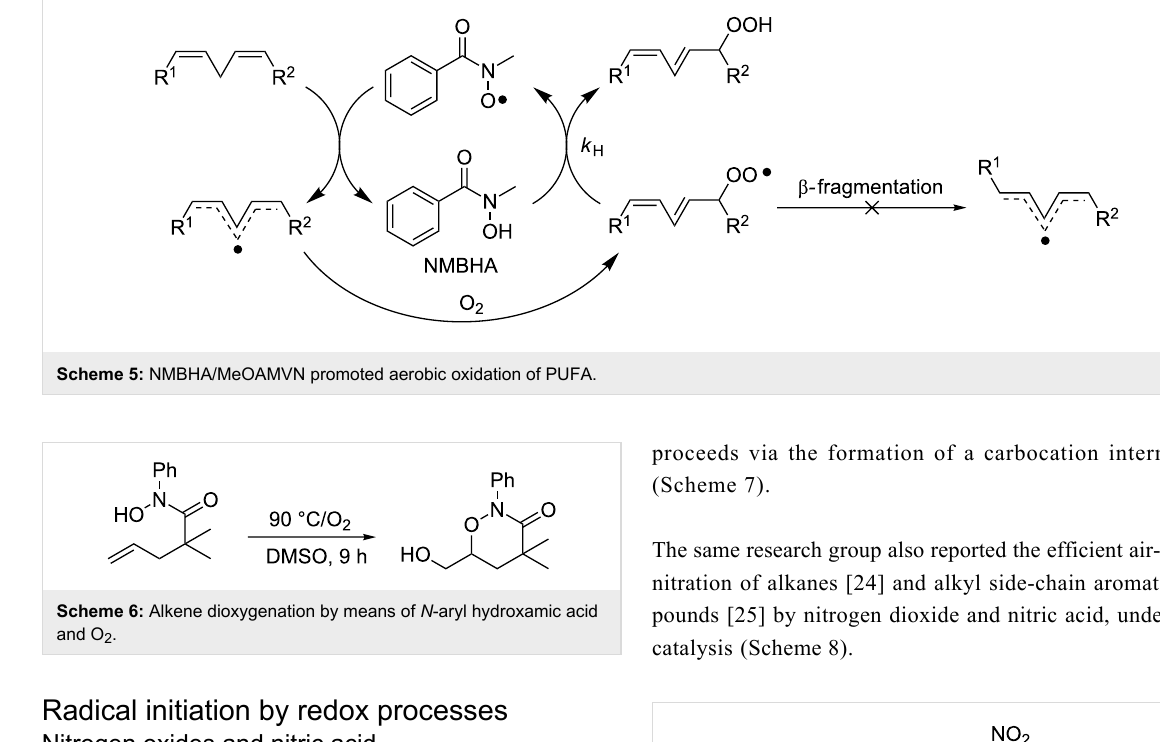
Radical initiation by redox processes Nitrogen oxides and nitric